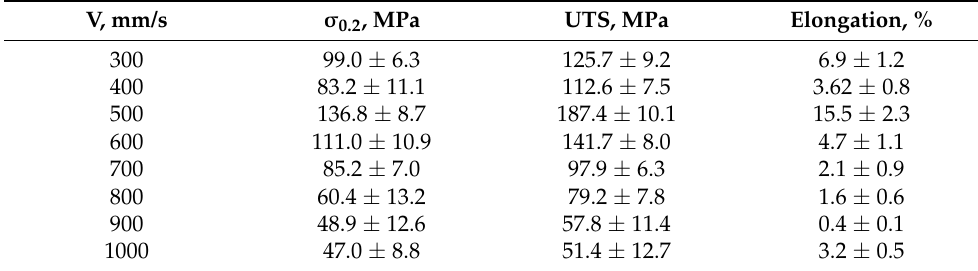
Figure 4. Fine dendritic structure after LPBF with clearly seen melt pool ( a ) and grain ( b ) boundaries. Tensile properties of all synthesized samples using recycled powder were examined, and the results are listed in Table 2. Both yield strength ( σ 0.2 ) and ultimate tensile strength (UTS) are expectedly slightly lower than obtained by Grigoryants et al. [36] using virgin atomized powder at the same LPBF machine and synthesis regimes, while the elongation of the best sample in the present study is even higher. Table 2. Mechanical properties of Cu-0.5Cr alloy fabricated using recycled powder depending on laser scanning speed.